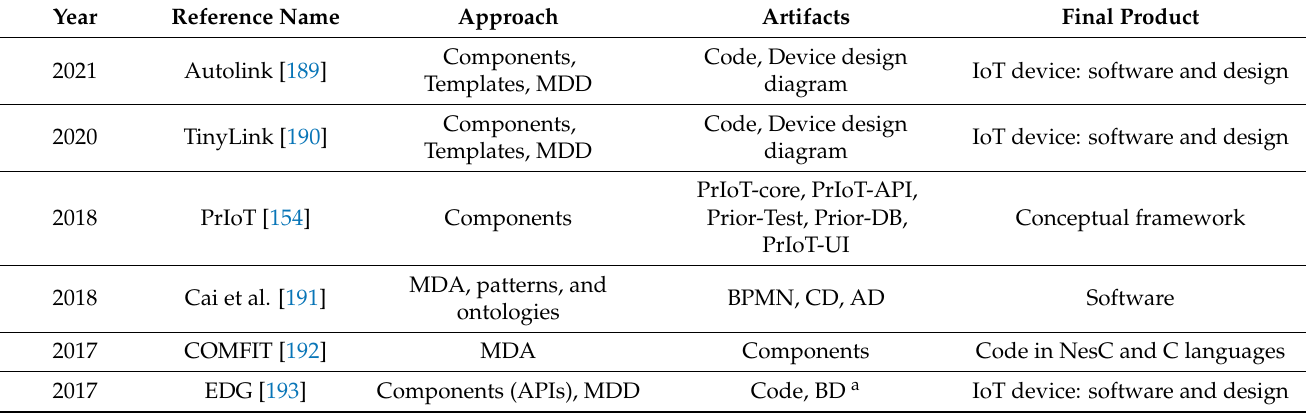
Table 4. Main features of platforms, frameworks, and tools for the development of